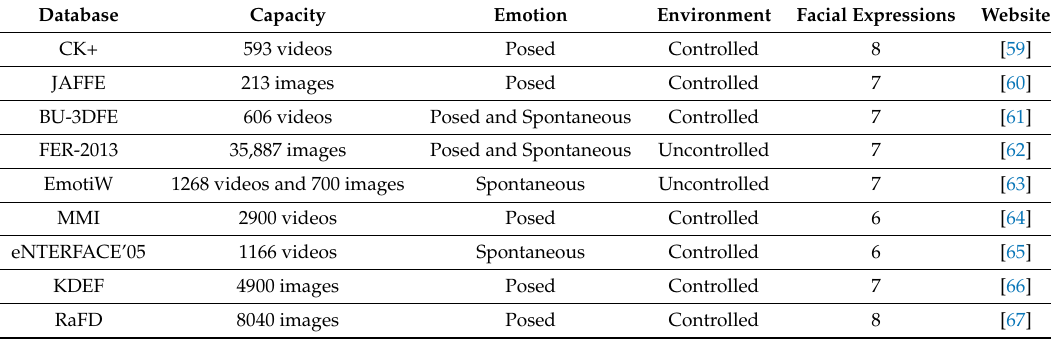
Table 1. Summarized FER